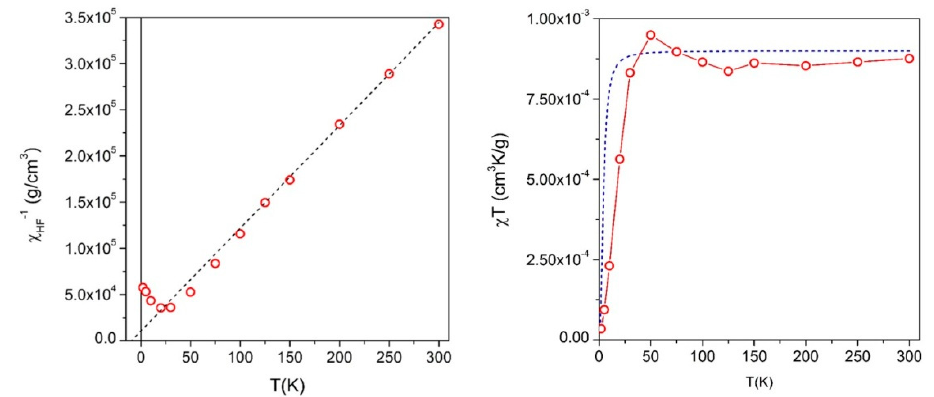
Figure 17. ( Left panel ) reciprocal of the high-field susceptibility χ HF − 1 as a function of temperature in sample NiX735C—12 min. Symbols: experimental data, dotted line: high-temperature linear fit; ( right panel ) χ HF T product as a function of temperature. Symbols: experimental data, line: expected behavior using the magnetic moment per ion obtained fitting the linear part of the χ HF − 1 curve to a modified Curie law.